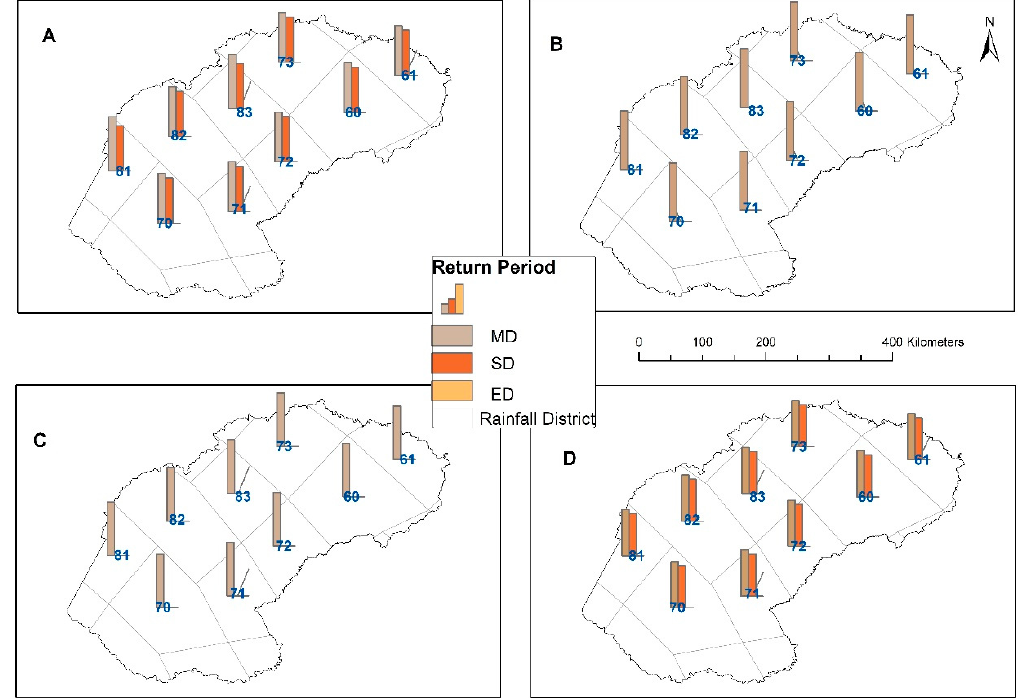
Figure 10. Return period based on extreme frequency analysis for dry period in the Free State Province: ( A ) EDI; ( B ) SPI-3; ( C ) SPI-6; ( D ) SPI-12, from 1980 to 2019 (MD, moderately dry; SD, severely dry; ED, extremely dry).3.6. Wet Return Periods Based on Extreme Frequency Analysis (EFA) in the Free State Province.